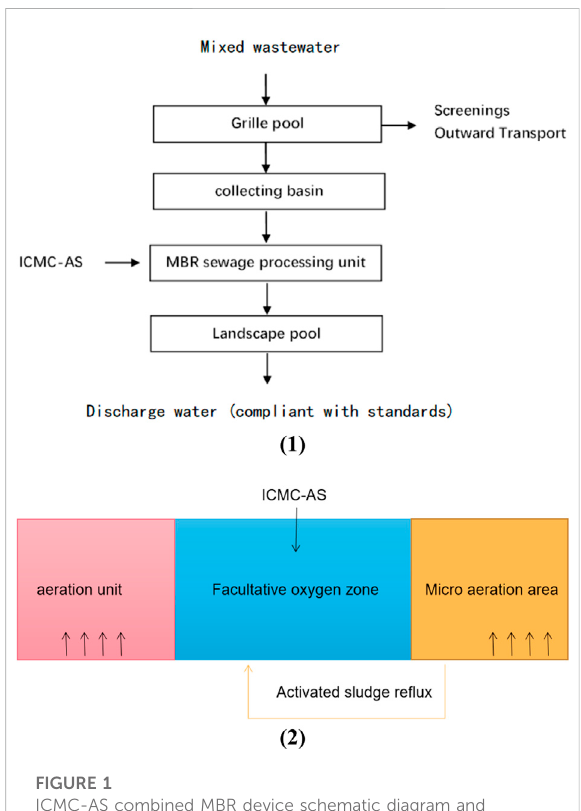
FIGURE 1 ICMC-AS combined MBR device schematic diagram and process fl ow chart. 1) Flow chart of Fe – C microelectrolysis combined with MBR process. 2) Schematic diagram of ICMC-AS combined MBR